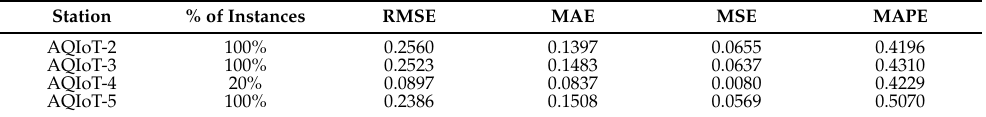
Table 6. Error metrics results of LSTM deep learning model during testing and validation stages (outdoor